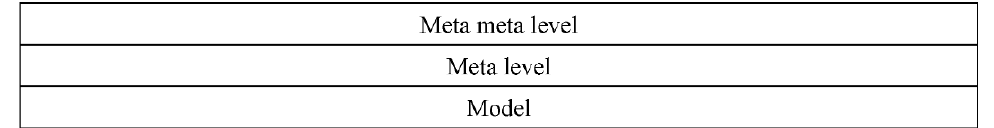
Figure 9. DDTM hierarchy.